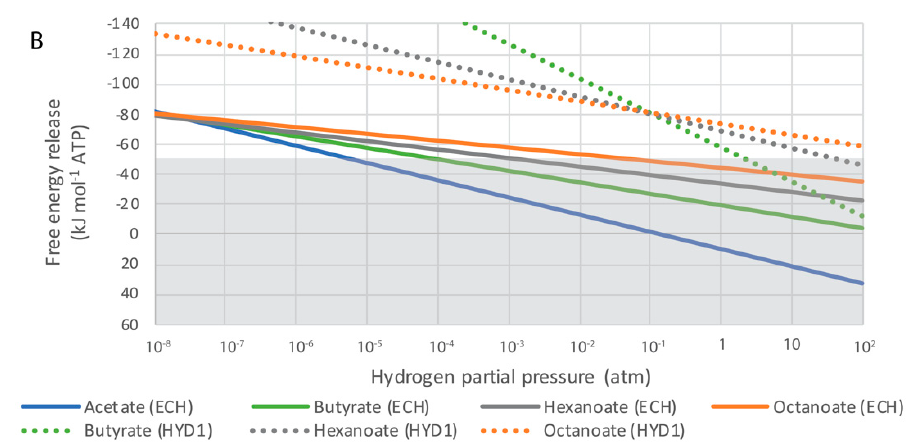
Figure 8. Free energy release for different products from ethanol under a range of H 2 partial pressures. Plots show the overall free energy release (A) and the free energy release per mol of ATP (B). Areas shaded in gray are considered infeasible and the dashed lines represent scenarios with Hyd1 as a hydrogenase instead of ECH.